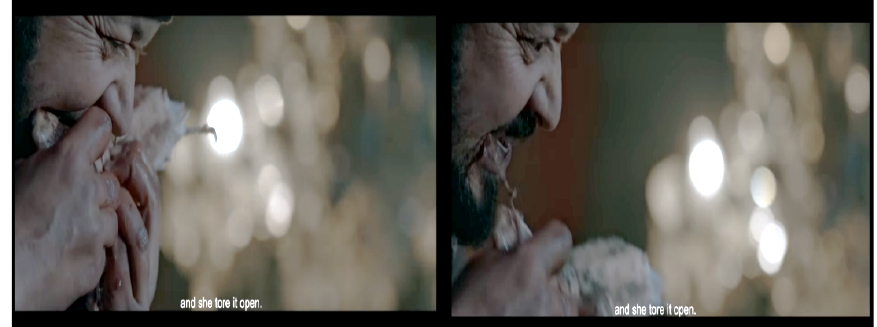
Figure 9: A fierce cannibale coming from theatre